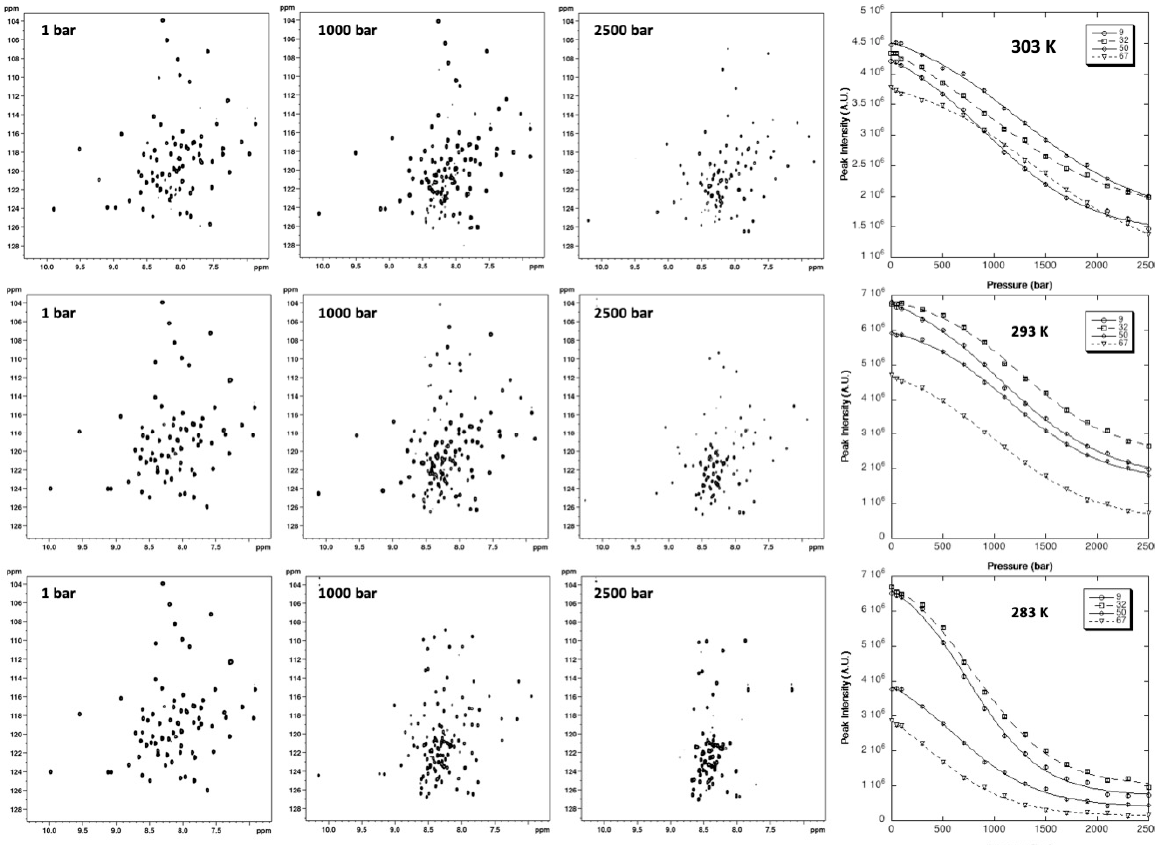
Figure 4. NMR detected high-pressure unfolding of GIPC1-GH2 at 30 ◦ C, 20 ◦ C, and 10 ◦ C (from top to bottom). At each temperature, examples of [ 1 H, 15 N] HSQC at 1, 1000, and 2500 bar are displayed from left to right. The rightmost panels report overlays of four (residues K9, T32, L50, and V67) residue-specific experimental denaturation curves obtained from the fits of the pressure-dependent sigmoidal decrease of the corresponding residue cross-peak intensities in the HSQC spectra with Equation (4).